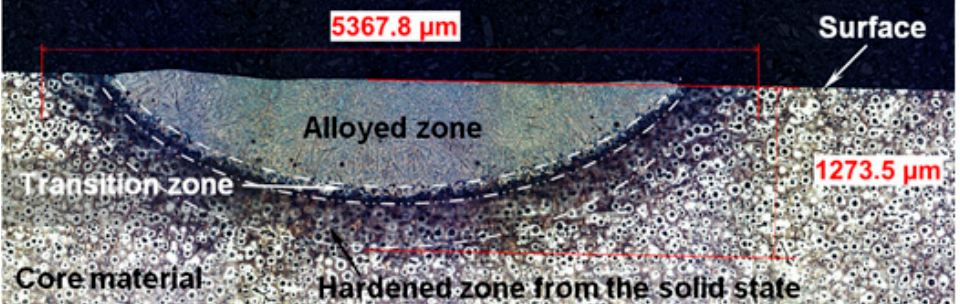
Figure 5. The cross-section of the surface layer of the nodular cast iron after the laser treatment (optical microscope, etched with nital 3%).